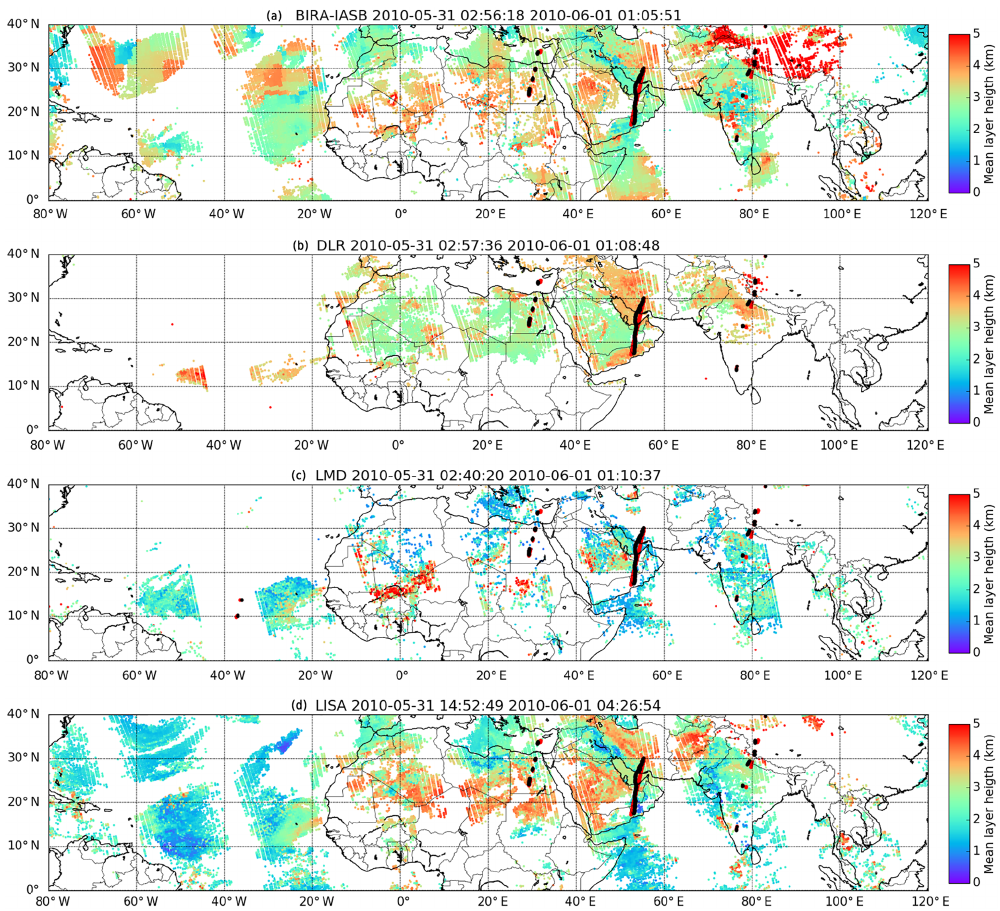
Figure 2. The IASI dust-layer height from the BIRA-IASB (a) , DLR (b) , LMD (c) and LISA (d) analysis. The CALIOP profiles identified as dust within 500km and 5h time differences from nearest IASI pixel are overlaid (red dots). The location of the CALIOP height after shifting to IASI overpass time is shown by the black dots. The time range (UTC) in the title gives the times of the first and last CALIOP points